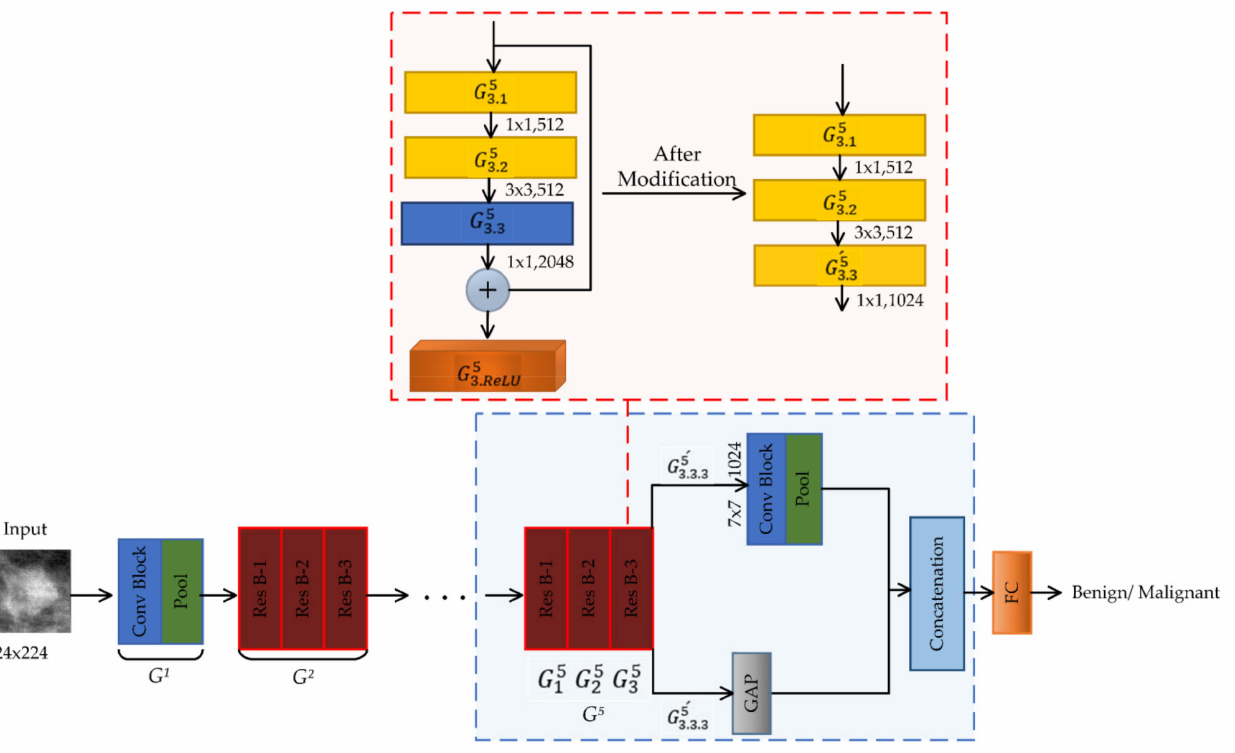
Figure 7. DIIResNet-50 model.